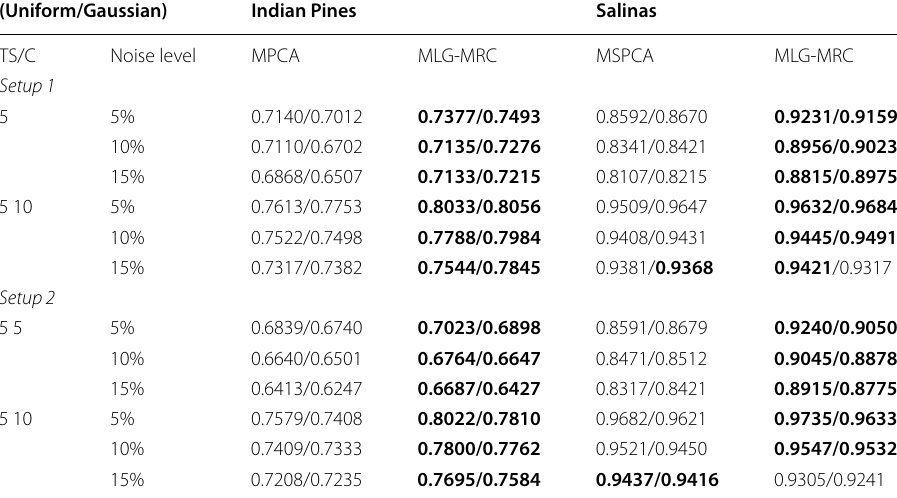
Table 5 Overall accuracy in noisy environment